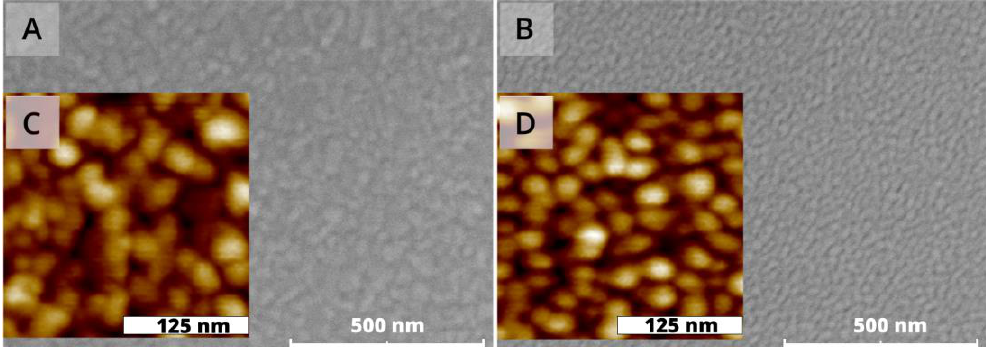
Figure 2. ( A ) Scanning electron micrograph of copper thin film deposited at room temperature. ( B ) Scanning electron micrograph of copper thin film deposited at room temperature protected by 3 nm of Al 2 O 3 .( C ) Atomic force micrograph of copper thin film deposited at room temperature. ( D ) Atomic force micrograph of copper thin film deposited at room temperature protected by Al 2 O 3 . An RMS topography value of 1.0 nm was obtained on the bare copper.